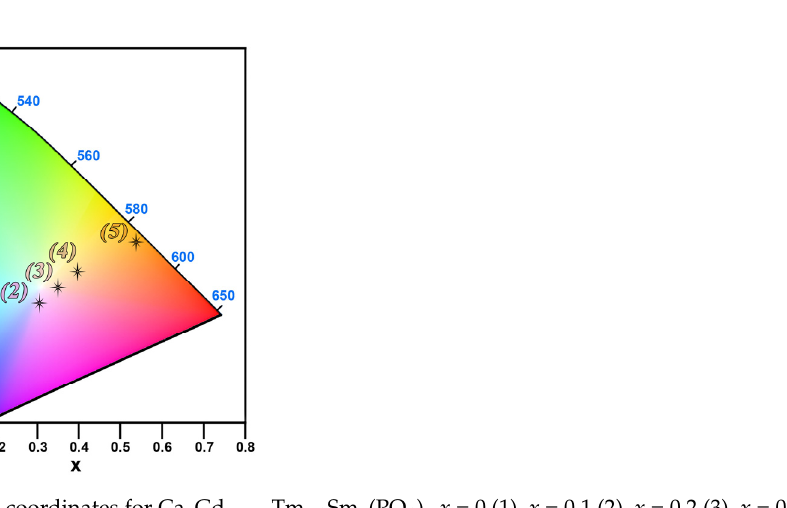
Figure 9. Color coordinates for Ca 9 Gd 0.9 − x Tm 0.1 Sm x (PO 4 ) 7 x = 0 (1), x = 0.1 (2), x = 0.2 (3), x = 0.3 (4) and Ca 9 Gd 0.9 Sm 0.1 (PO 4 ) 7 (5).